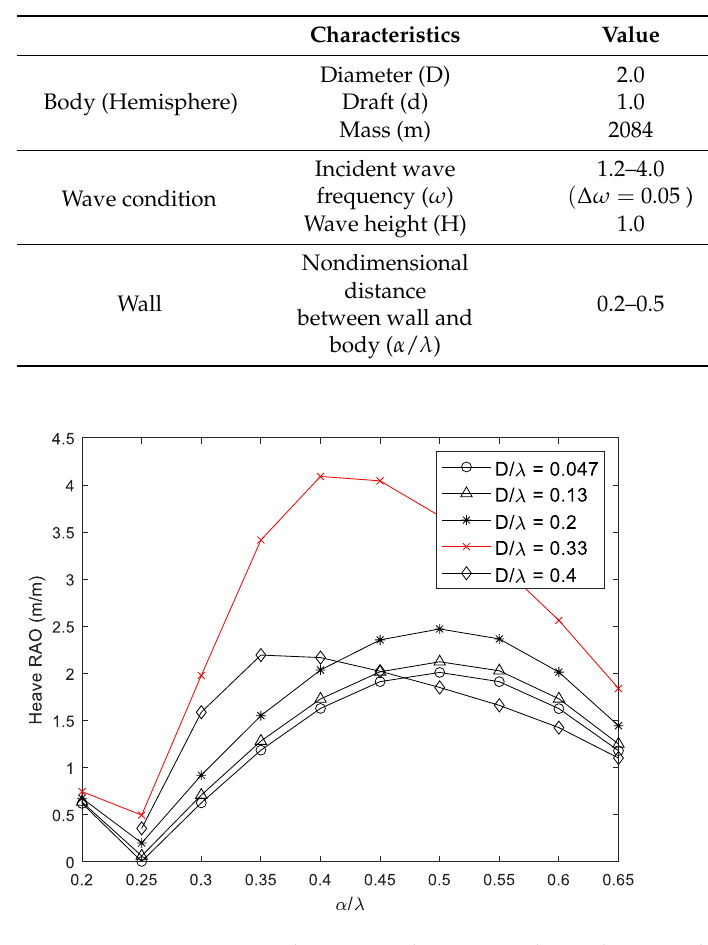
Figure 17. Motion RAOs of the WEC under different conditions.